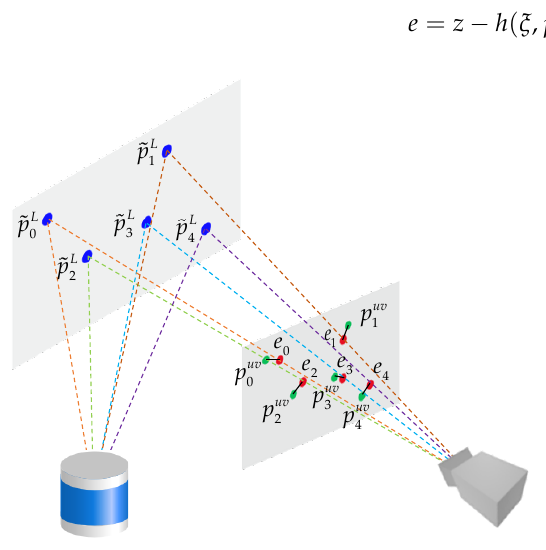
Figure 6. Re-projection error of characteristic corner points.